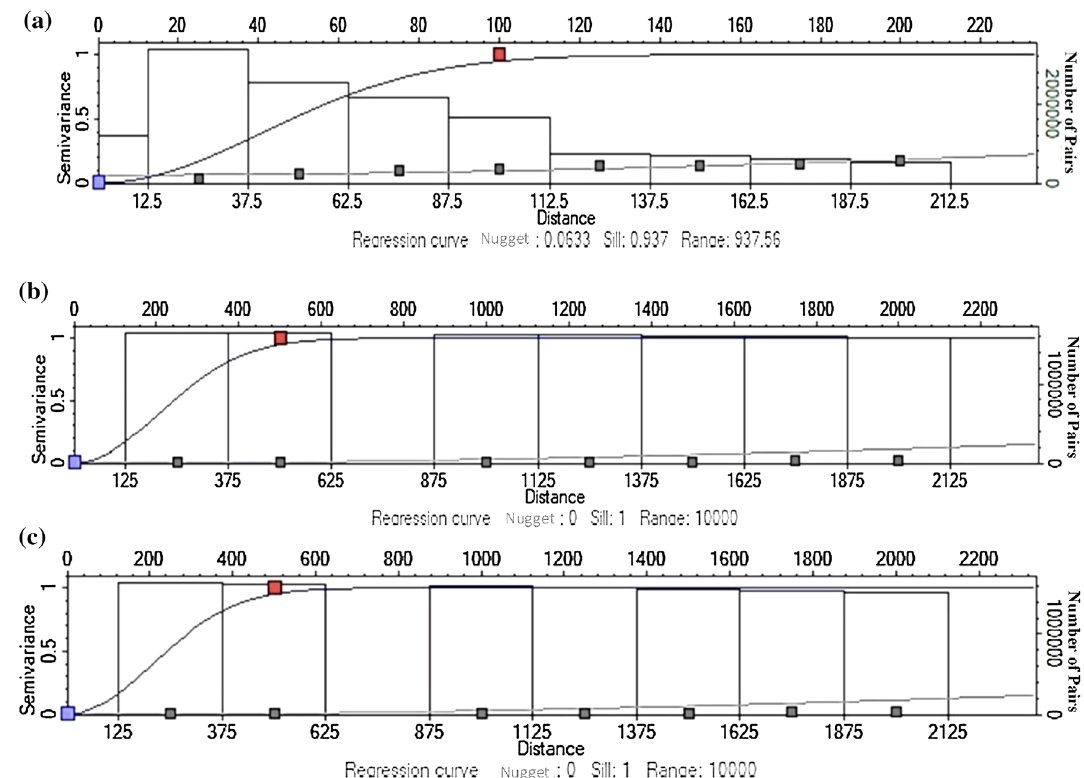
Fig. 10 Semi variogram of final Pore pressure Cube a vertical, b horizontal major direction azimuth zero deg., c minor direction azimuth 270